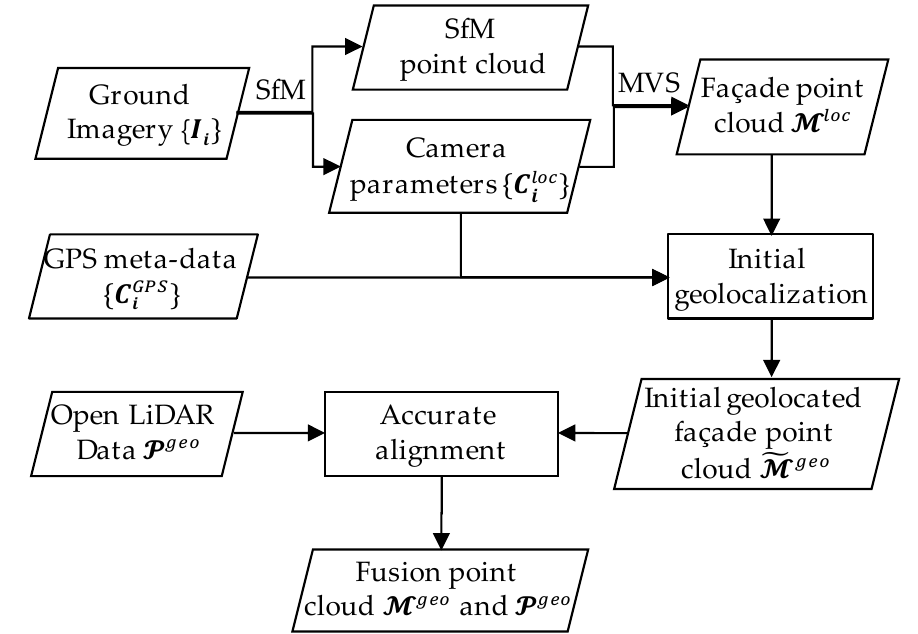
Figure 1. The overview of the proposed method.